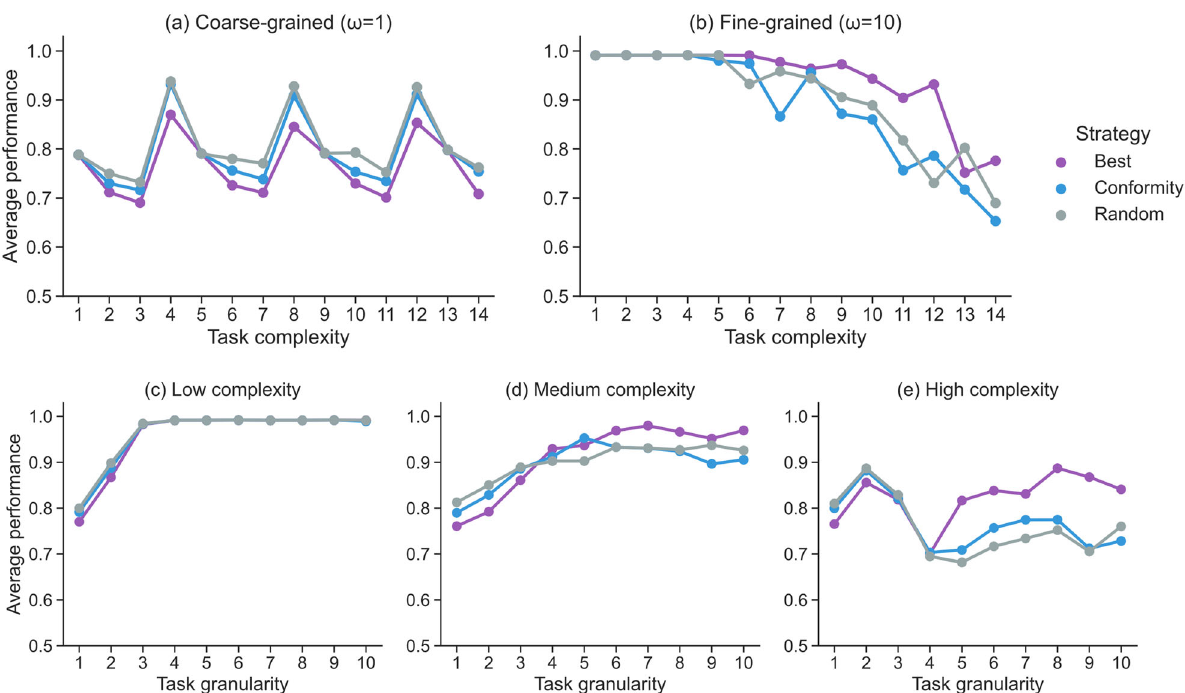
Fig. 3 Performance of groups using different strategies in easy-to-hard tasks. Two panels in the fi rst row show the results in a coarse-grained and b fi ne- grained easy-to-hard tasks with different complexity. Three panels in the second row show the results in easy-to-hard tasks with c low, d medium, and e high complexity. Purple lines: the best strategy. Blue lines: the conformity strategy. Gray lines: the random strategy. Based on a fully connected network with N = 100 individuals and the normal SQB